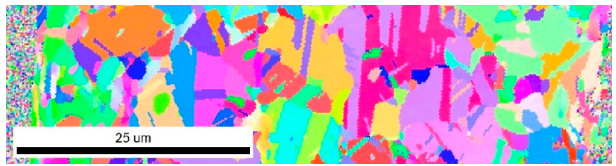
Figure 1. EBSD map of one of the stranded wires cut parallel to the wire direction.